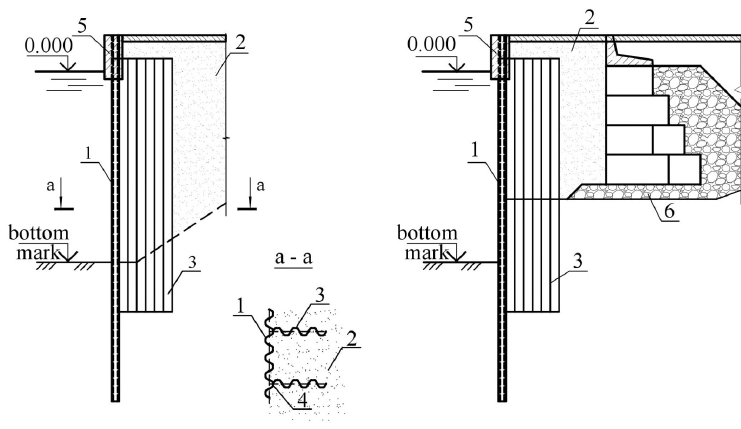
Fig. 1. Tongue-and-groove wall with buttresses: a – building a new berth; b – during the berth reconstruction; 1 – front tongue-and-groove wall, 2 – backfill, 3 – transverse rows of piles, 4 – lock joints, 5 – cap beam, 6 – existing design